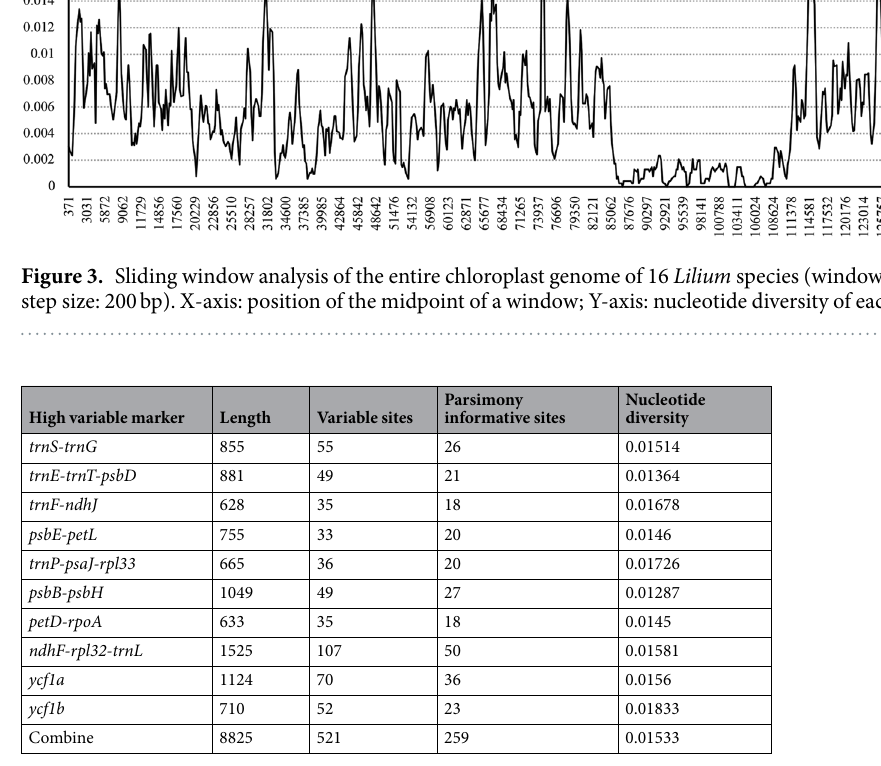
Table 4. Ten regions of highly variable sequences of Lilium